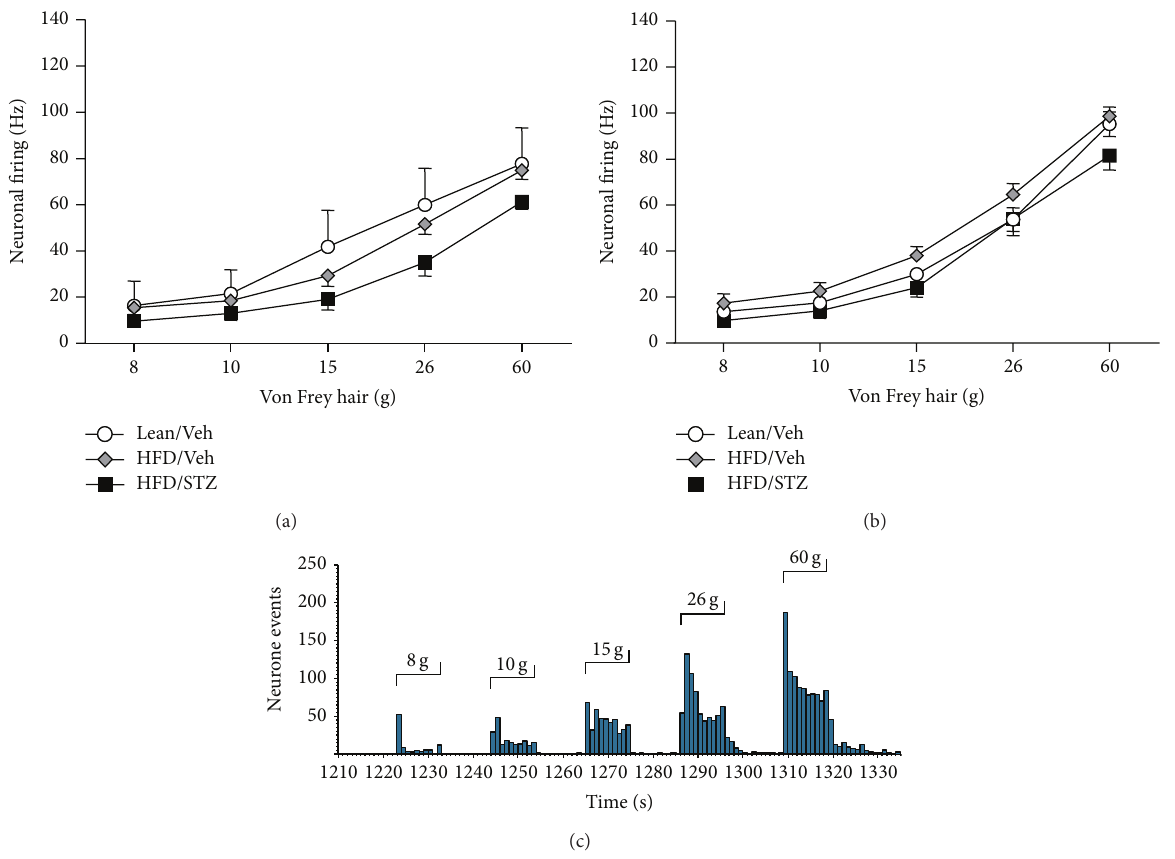
Figure 3: Effects of the HFD/STZ model on mechanically evoked responses of dorsal horn neurons. Comparison of the mechanically evoked responses of wide dynamic range dorsal horn neurones following stimulation of the receptive field on the hindpaw with a range of innocuous and noxious von Frey hairs in the Lean/Veh controls, HFD/Veh controls, and diabetic HFD/STZ rats at (a) day 49 and (b) day 78. Data are meanfrequencyoffiring ± SEM, 𝑛 = 6 ratspergroup,withanaverageof15neuronespergroup.(c)Representativetraceoftheevokedresponse of a single wide dynamic range dorsal horn neurone following mechanical (8, 10, 15, 26, and 60g) stimulation of the hindpaw receptive field in the anaesthetised HFD/Veh